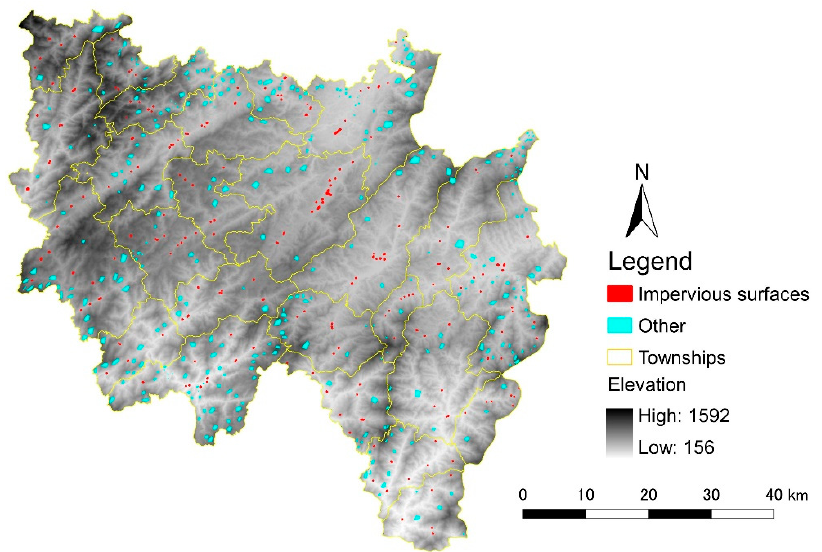
Figure 3. Spatial distribution of training sample polygons.